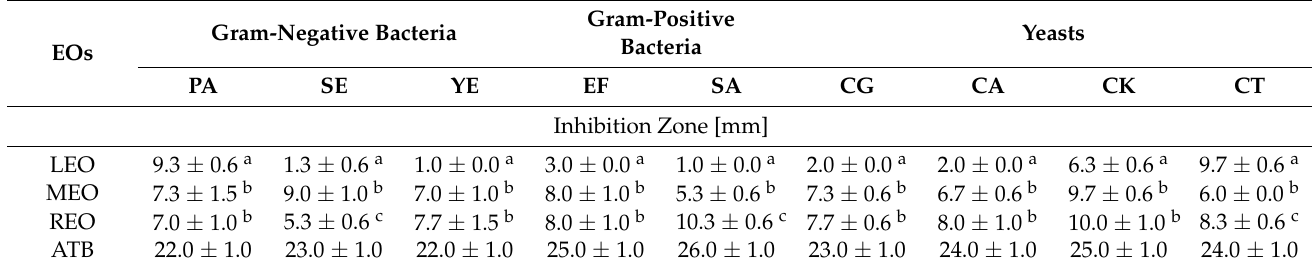
Table 3. Antimicrobial activity of EOs (inhibition zone in mm).